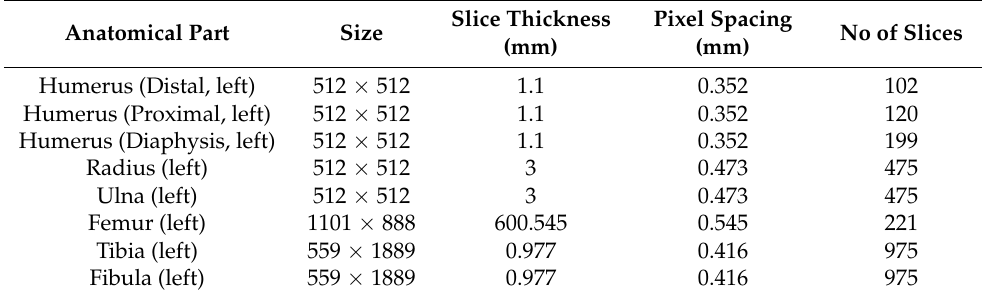
Table 1. Technical features of CT scans of the bones